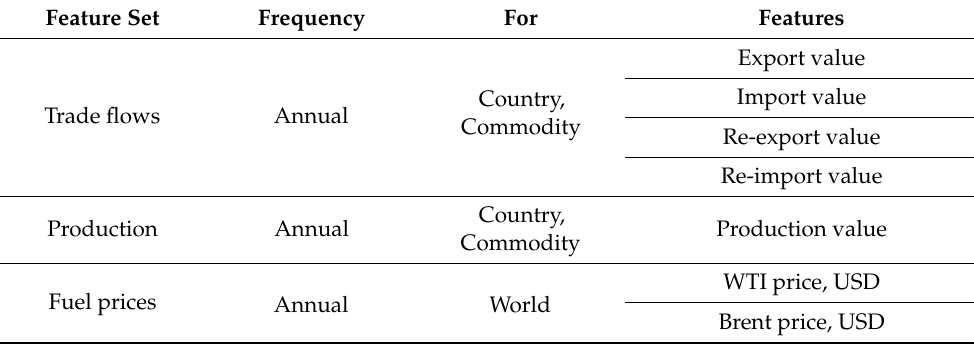
Table 1. Feature set for the mid-term wheat export and production